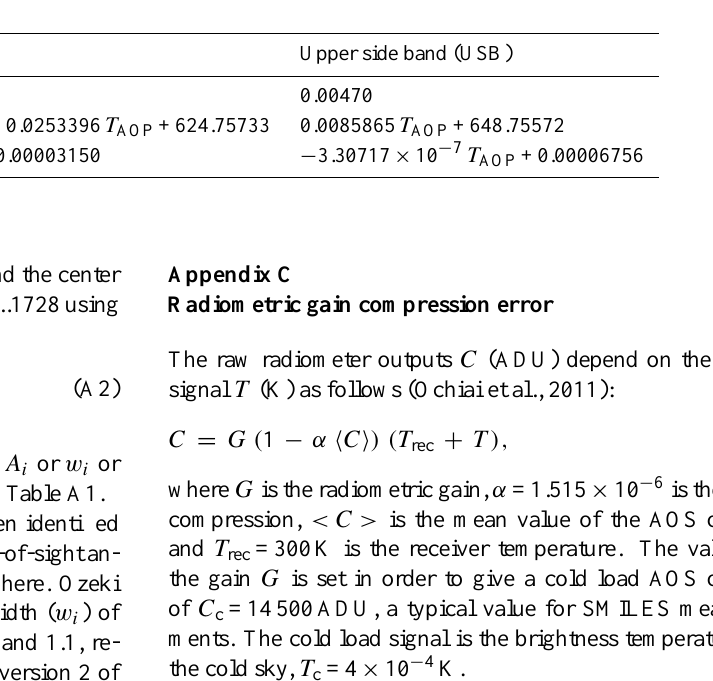
Table A1. Side band response parameters for the lower side band (LSB) and upper side band (USB) (Eq. B1). The parameters a and ν 0 vary with the temperature of the Ambient Temperature Optics